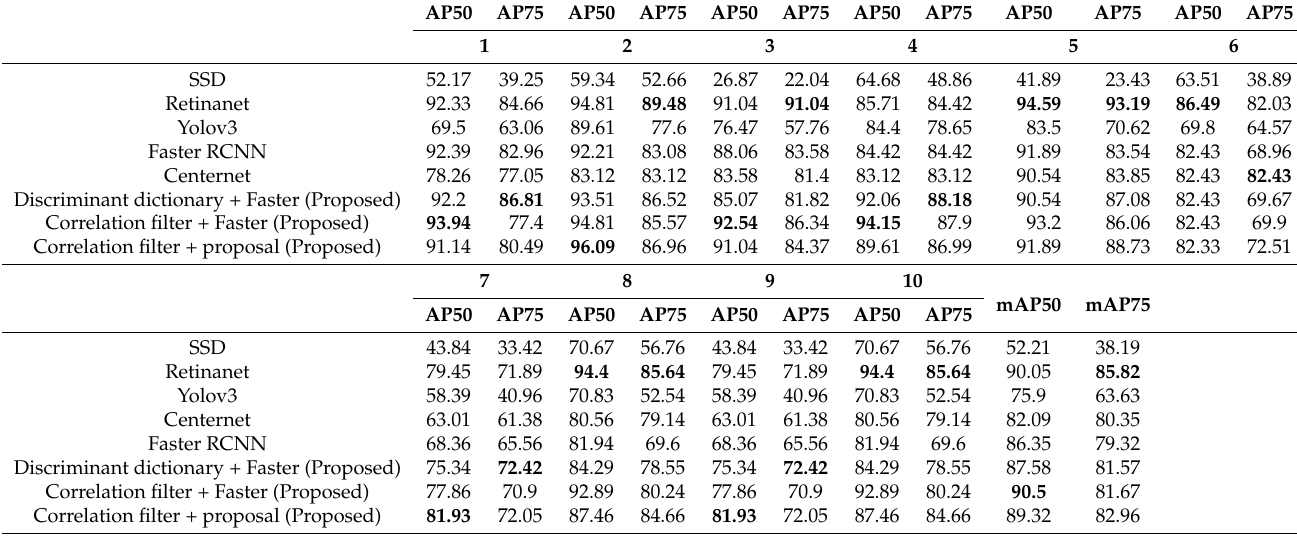
Table 2. Comparison of detection results by different algorithms in different individuals